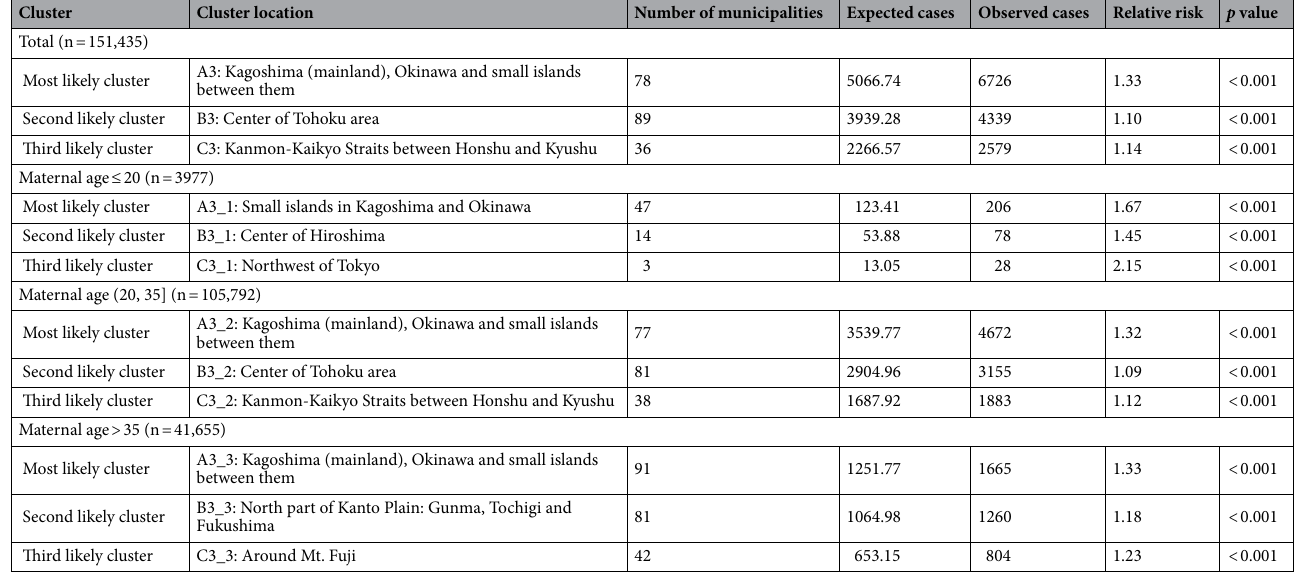
Table 4. Geographical clusters of LBWpre in